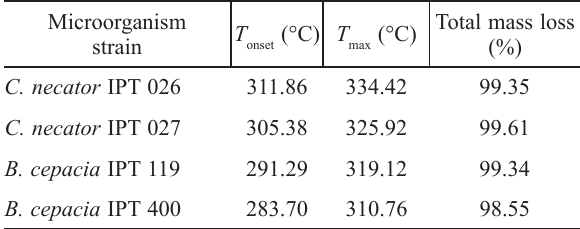
Table 4 – Initial degradation (T ) and maximum decompo- onset sition temperatures (T ), along with total weight loss of PHAs max produced by C. necator and B. cepacia strains using